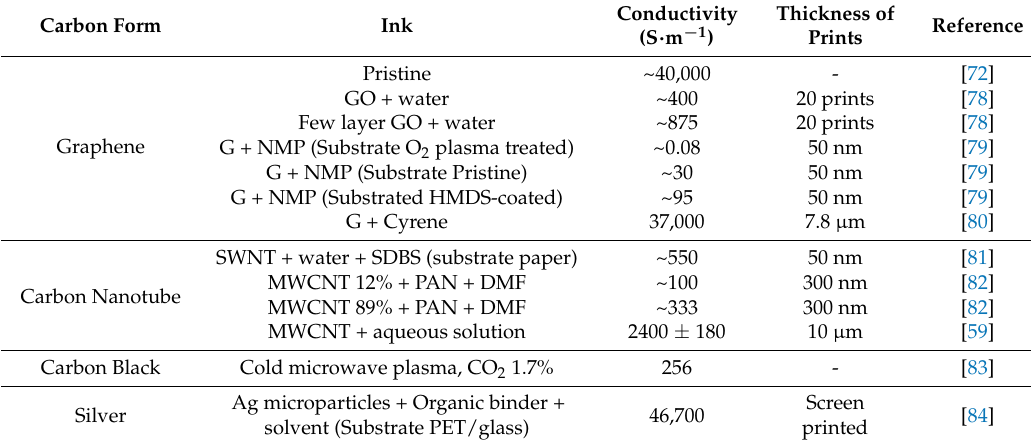
Table 6. Various carbon based ink examples from the literature, showing the relationship of ink medium with conductivity and